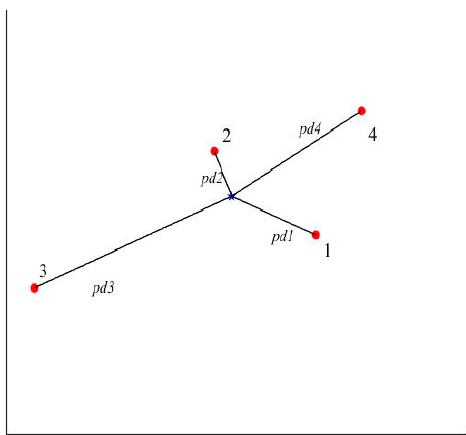
Figure 3. Normalized Euclidean distance in a two-dimensional (x-y) coordinate system. Algorithm 1.